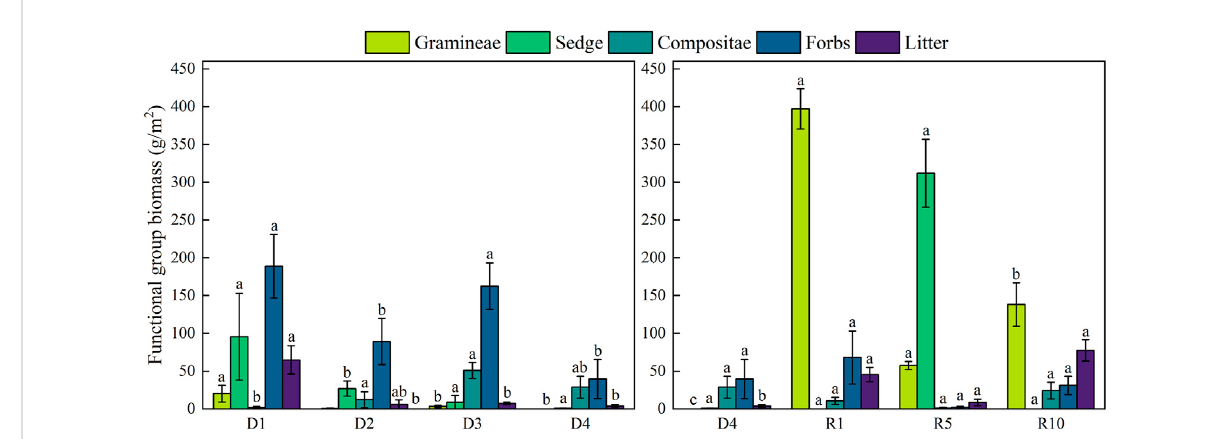
FIGURE 3 Changes in functional group biomass at different degradation stages and recovery years.